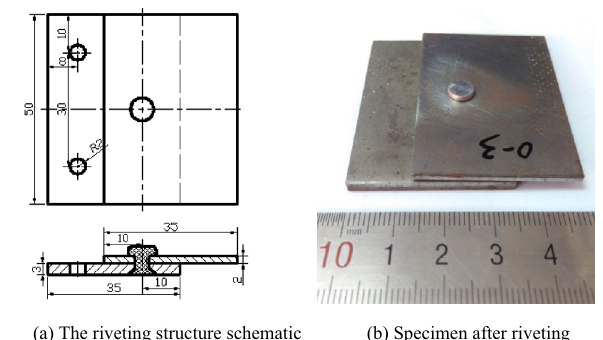
Figure 6. Test structure of shear mechanical properties.